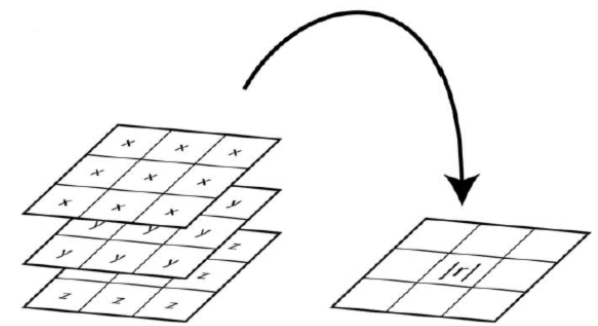
Figure 3. Resultant vector, r , is obtained by summing up the x , y and z components of all pixels, n , within the neighbourhood win- dow. Graphics from Sappington et al. (2007).